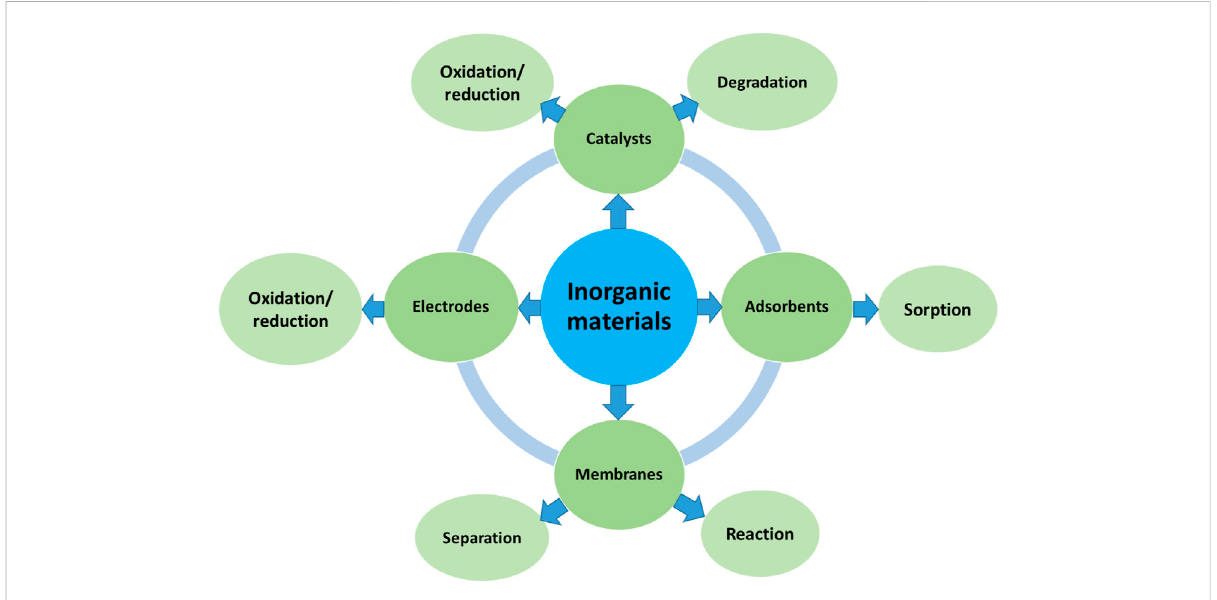
FIGURE 1 Typical applications of inorganic materials in the energy and environmental fi